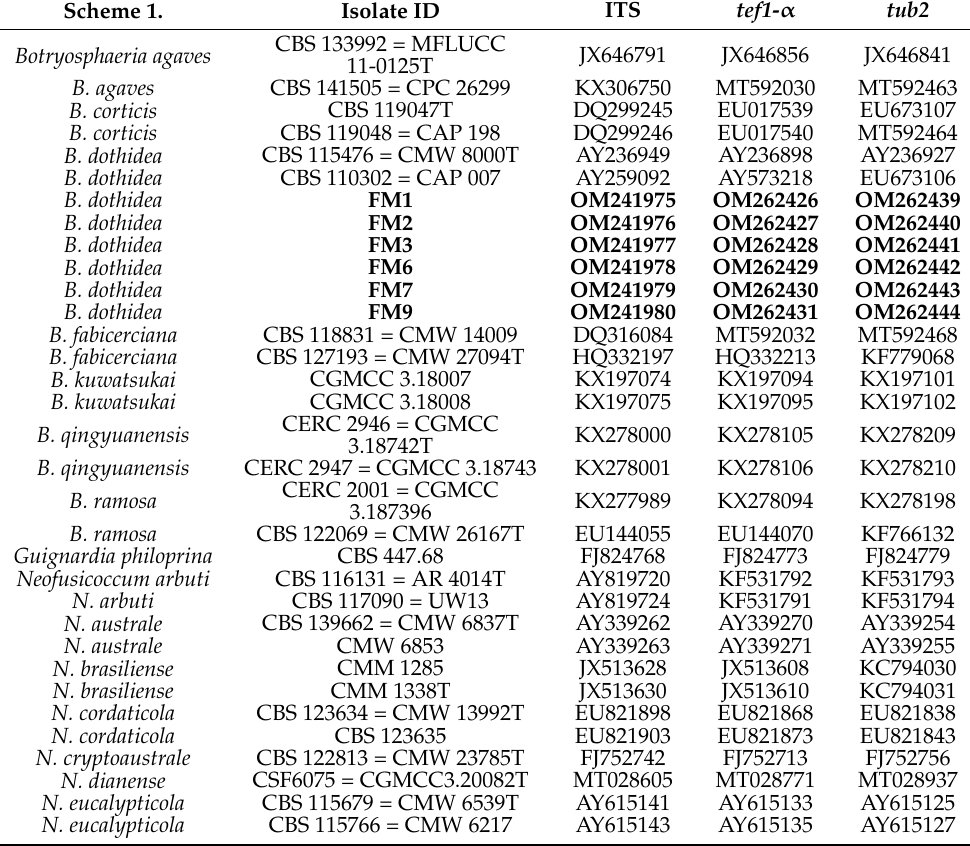
Table 1. Information on fungal isolates used in the phylogenetic analyses and their corresponding GenBank accession numbers. Isolates in bold are from this